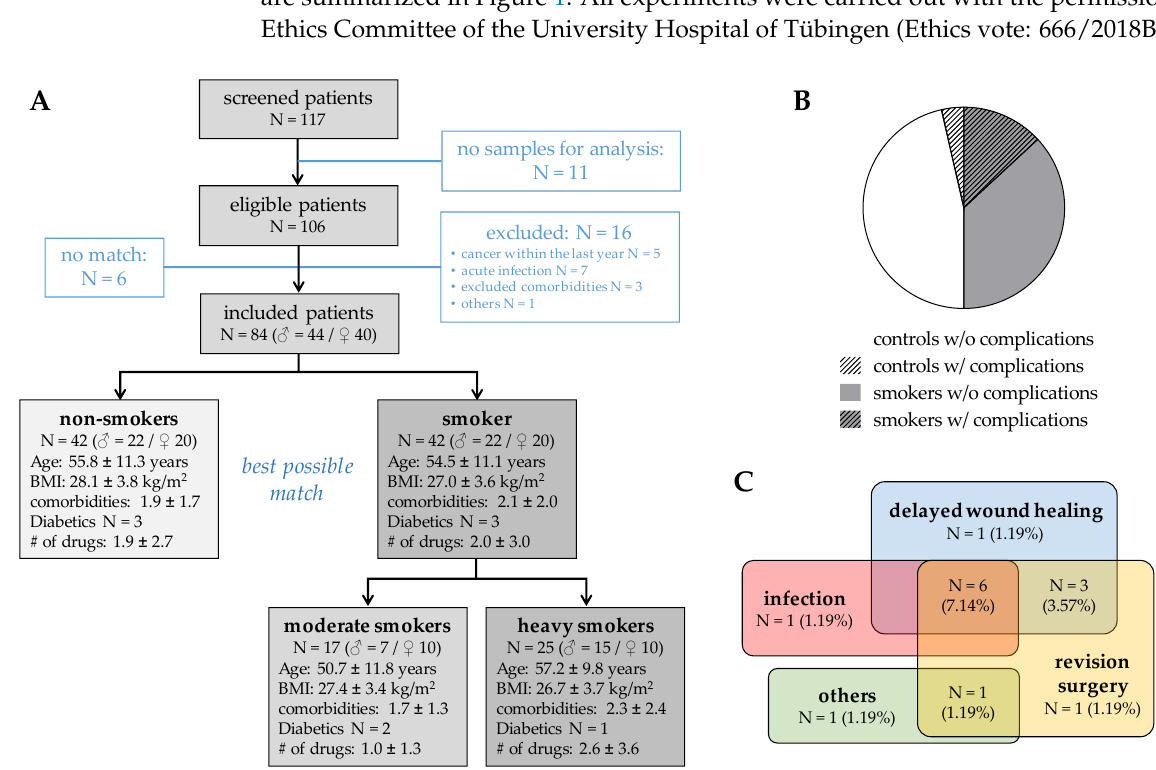
Figure 1. Overview of the patients prospectively collected to analyze the effect of smoking on neutrophilic PADI4 expression. ( A ) CONSORT diagram on the patients analyzed in this study. Smoking was recorded as packyears (PY). The complications rates in non-smokers and smokers are summarized as ( B ) pie chart and additionally as ( C ) VENN diagram to show multiple complications in one individual.